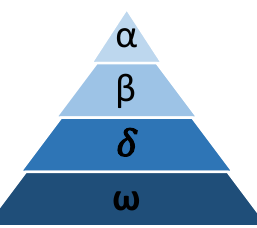
Figure 2. Hierarchy of grey wolf.